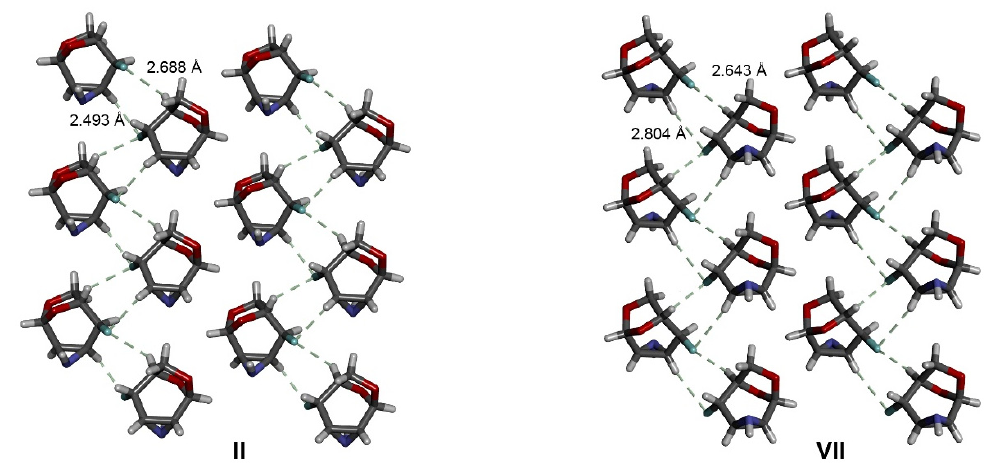
Figure 12. Interaction of fluorine atoms in the molecular packing of II (left) and VII (right).